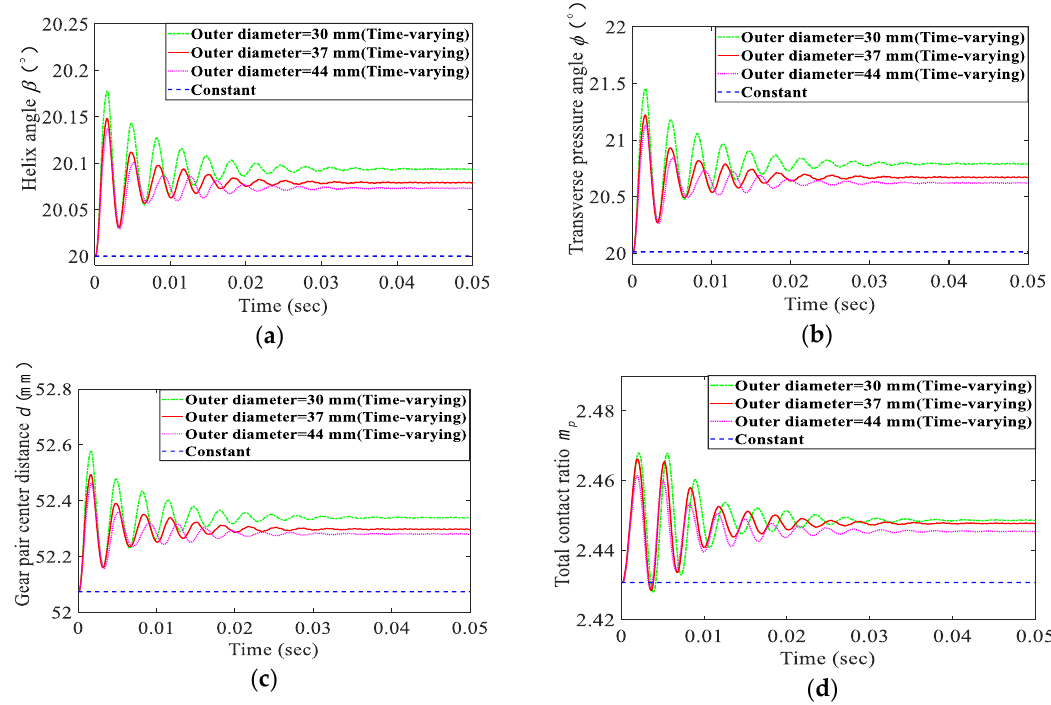
Figure 8. Time-varying and constant (a) helix angle, (b) transverse pressure angle, (c) gear pair center distance, and (d) total contact ratio under different outer diameters of the shaft.